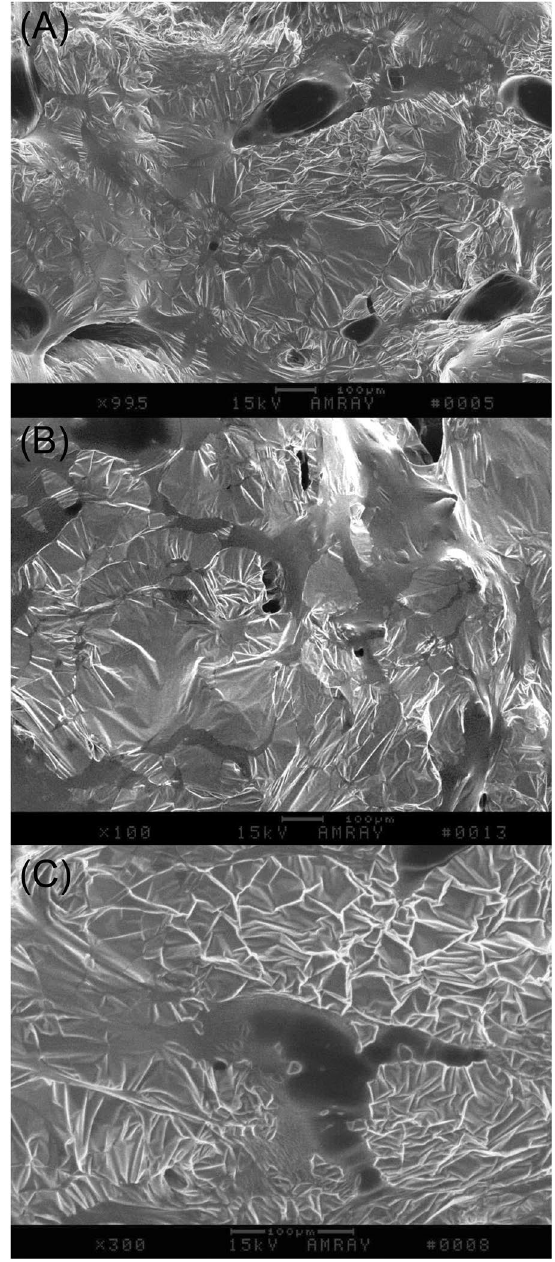
Figure 4. Representative SEM images of dark buckwheat honey H220 ( A ) and medium-color, H207 ( B ) honeys, indicating two-phase systems consisting of the dence globular structures dispersed in sugar solution. The scale bar is 100 µ m, magnification of images ( A ) and ( B ) is 99.5x. ( C ) Micrograph of globule at the magnification of 300x. The scale bar is 100 µ